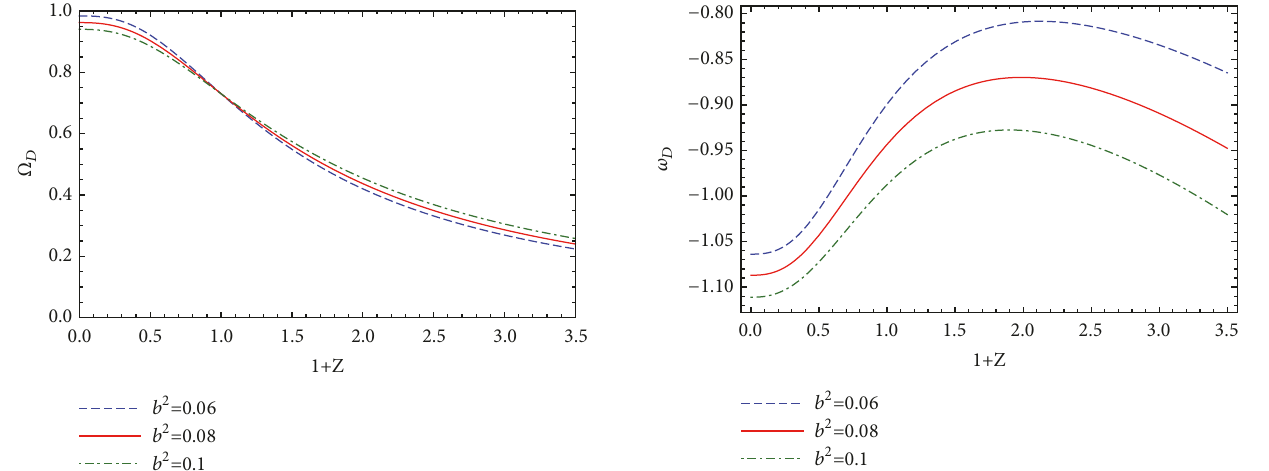
Figure 11: The evolution of 𝜔 𝐷 versus redshift parameter 𝑧 for interacting GDE in the DGP model. Here, we have taken Ω 𝐷 (𝑧 = 0) = 0.73 , 𝐻(𝑧 = 0) = 67 , and Ω = 𝑟 𝑐